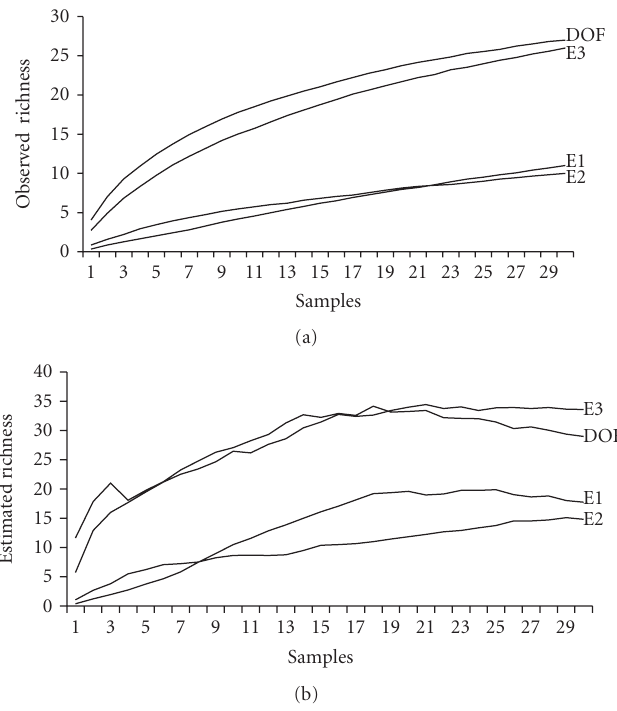
Figure 2: Curves for the observed (a) and estimated (b) richness of ants recorded in twigs from the leaf litter of the di ff erent forest types. DOF: dense ombrophilous forest, E1: commercial plantation managed for 7 years, E2: commercial plantation managed for 28 years, and E3: plantation left unmanaged for 28 years.